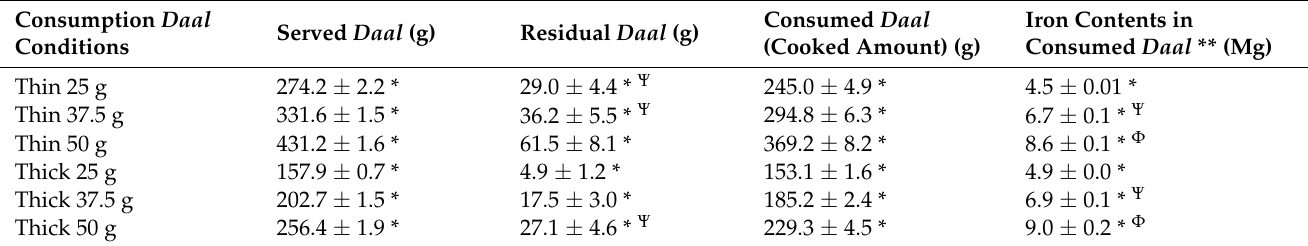
Table 3. Mean ± SEM differences for all conditions regarding served, residual, consumed daal meals and estimated iron consumption.